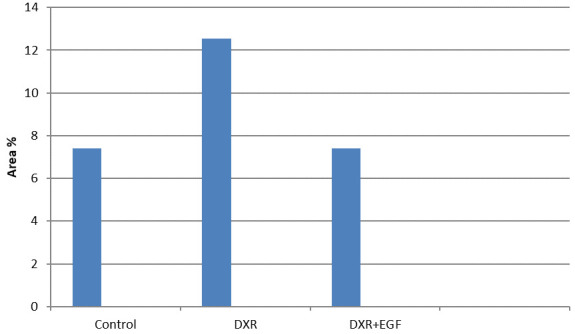
Area percent of Ki-67 reactivity in the submandibular salivary glands of all groups.